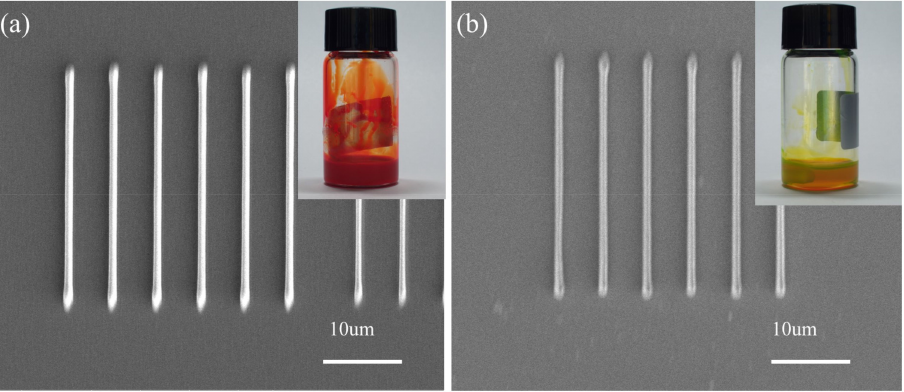
Figure 7. FE-SEM images illustrating the morphologies of the DLW processed 150 mg/mL red QD–polymer lines ( a ), 150 mg/mL green QD–polymer lines ( b ) at a P of 35 mW and a v of 30 µ m/s, and 150 mg/mL QD–polymer nanocomposites in the